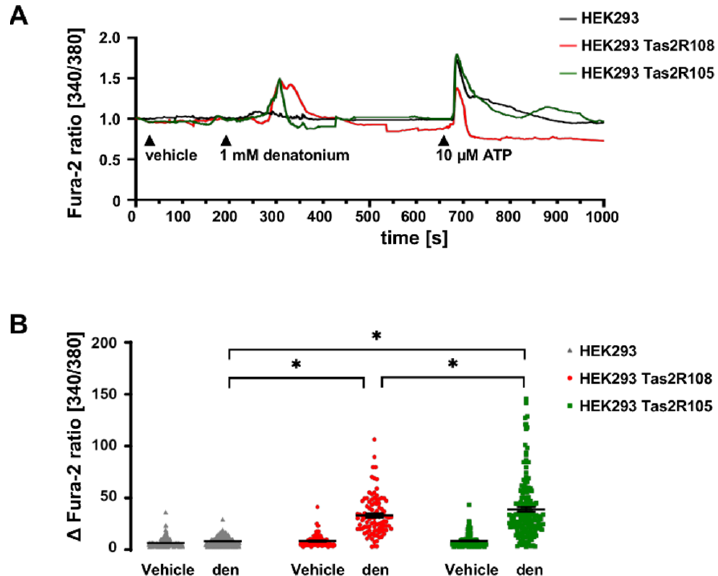
Figure 3. Denatonium activates Tas2R108 and Tas2R105. ( A ) Application of denatonium (1 mM) increased [Ca 2+ ] i in HEK293 cells transfected with Tas2R108 (red) or Tas2R105 (green) but not in untransfected HEK293 cells. The ATP (10 µM) control stimulus increased [Ca 2+ ] i in all cell lines. Representative curves for the Ca 2+ response. ( B ) The denatonium-induced [Ca 2+ ] i was increased in the HEK293 cells transfected with Tas2R108 ( n = 99) or Tas2R105 ( n = 160) compared to untransfected HEK293 cells ( n = 227) and the [Ca 2+ ] i response to denatonium was higher in HEK293 Tas2R105 cells than in HEK293 Tas2R108 cells (* p < 0.05).